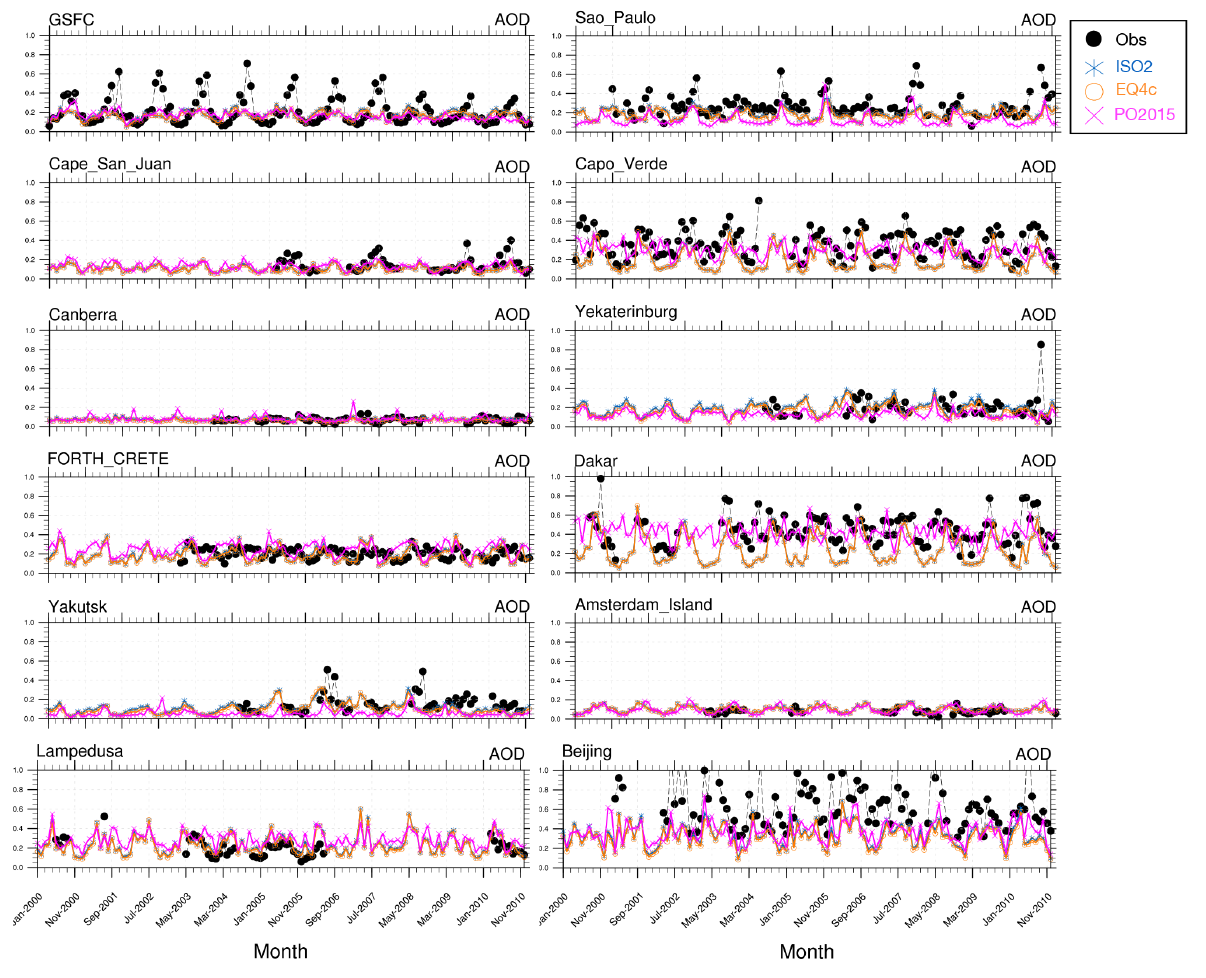
Figure 2. Selected AOD time series for 2000–2010 (monthly means) for the stations shown in Fig. 1, representing all regions of Fig. S1. EMAC results based on ISORROPIA II (ISO2), EQSAM4clim (EQ4c) versus AERONET observations (black circles), and Pozzer et al. (2015) (PO2015). Additionally, scatter plots (Figs. S2–S4) are shown in the Supplement for 537 AERONET stations (Fig.